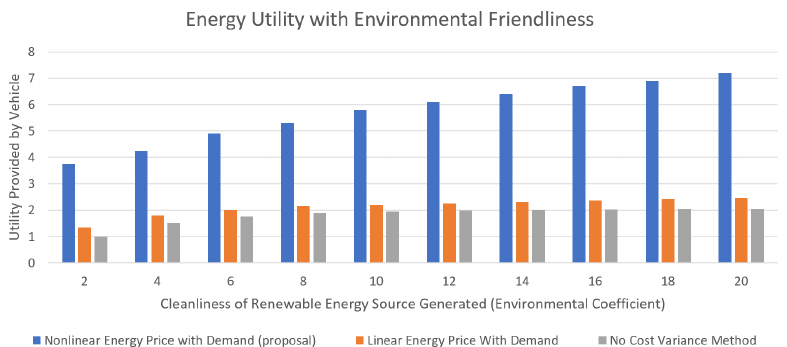
Figure 20. A model showing the environmental impact and utility of charging stations behaving under different methods, adopted from [117].